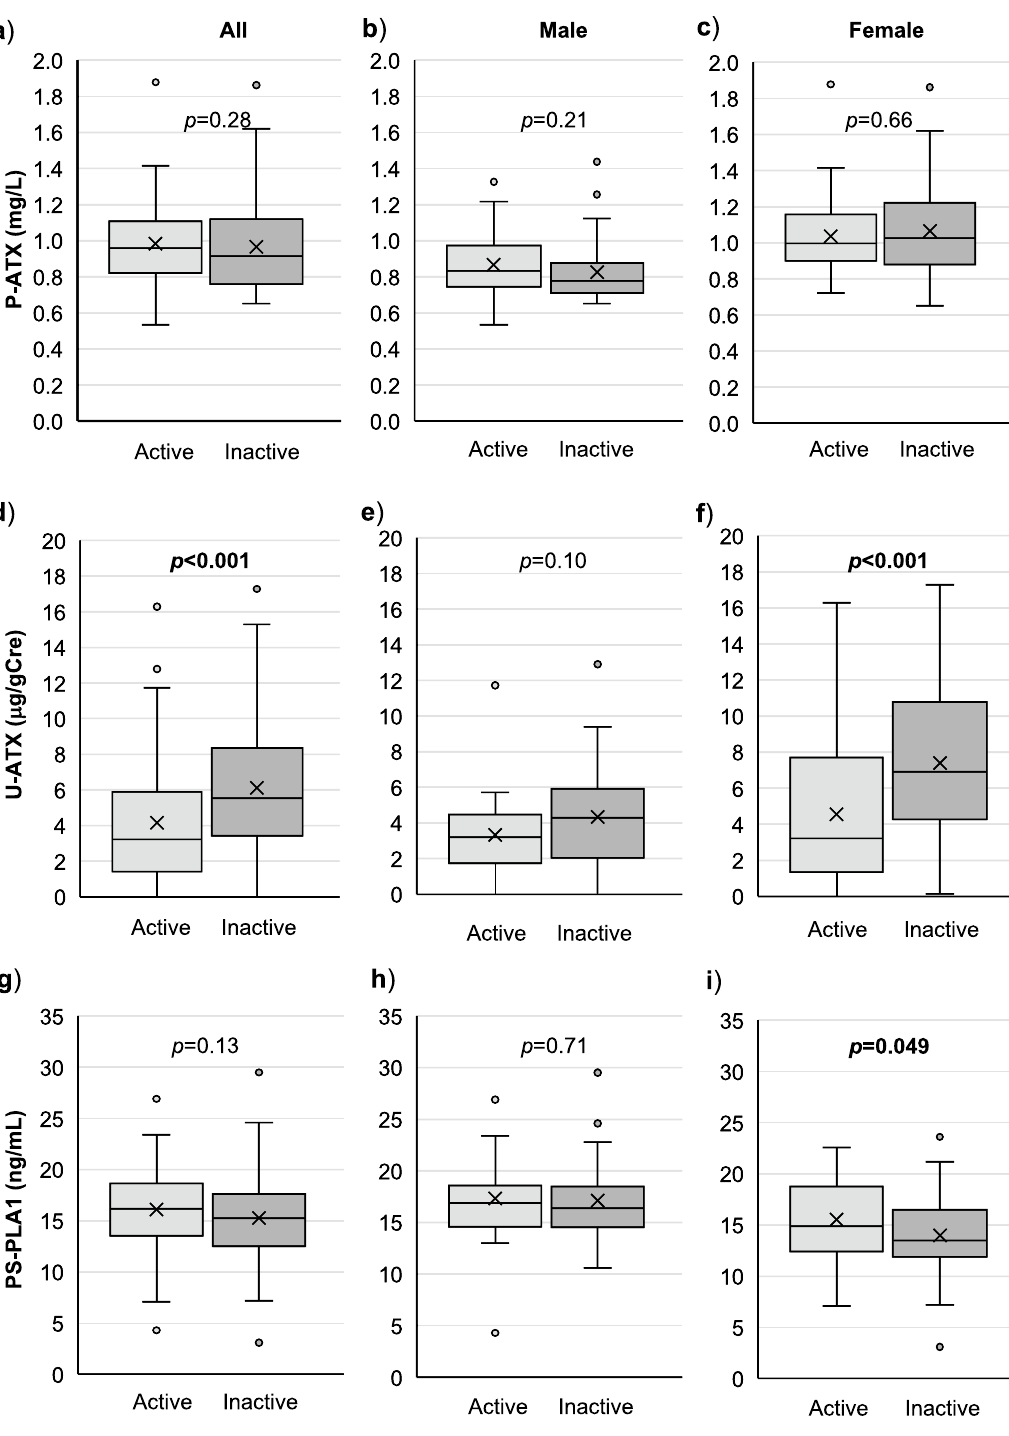
Figure 1. Comparison of the values of LPLs-producing enzymes between patients with active state and inactive state. Comparison of box plot of P-ATX ( a , b , c ), U-ATX ( d , e , f ), and PS-PLA1 ( g , h , i) levels between active and inactive state. Boxes indicate median and interquartile range, and whiskers indicate minimum–maximum range. Data were analyzed with Mann–Whitney U-test. Statistical significance was accepted as p < 0.05 and bold denotes values p <